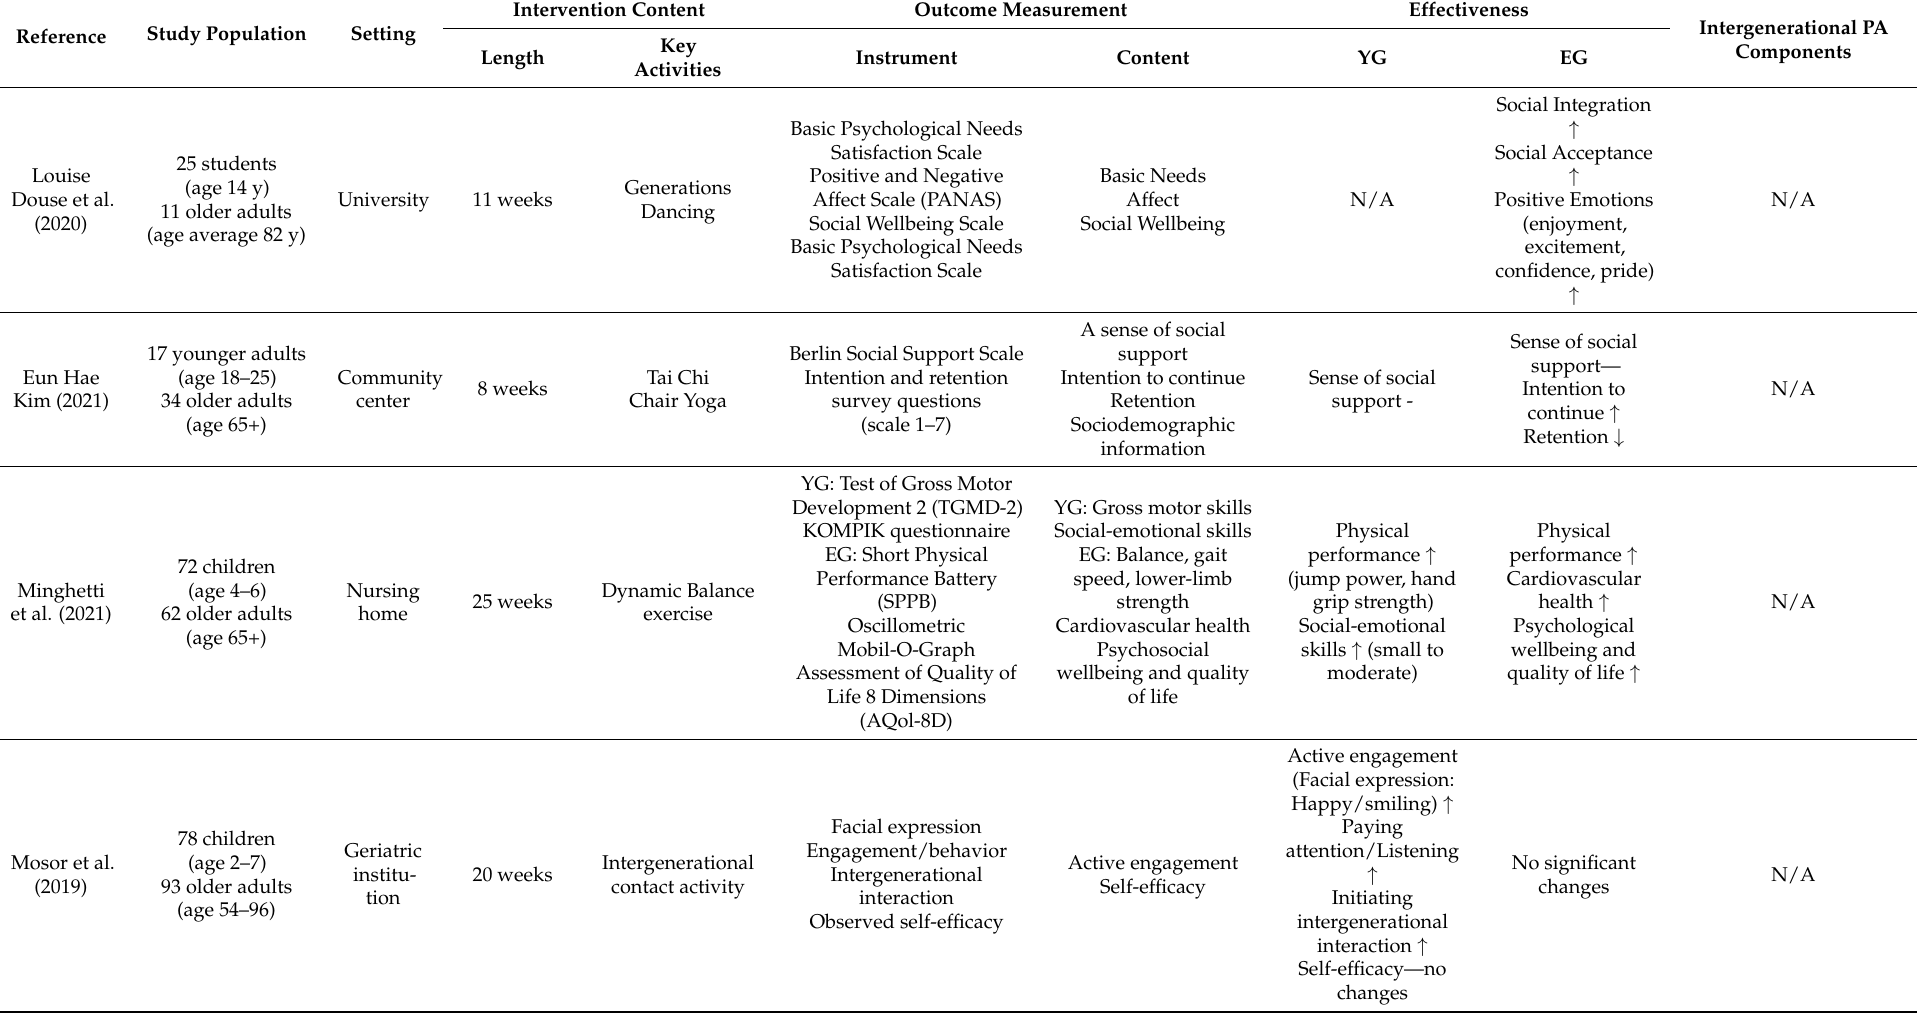
Table 1. Summary of intergenerational physical activity intervention